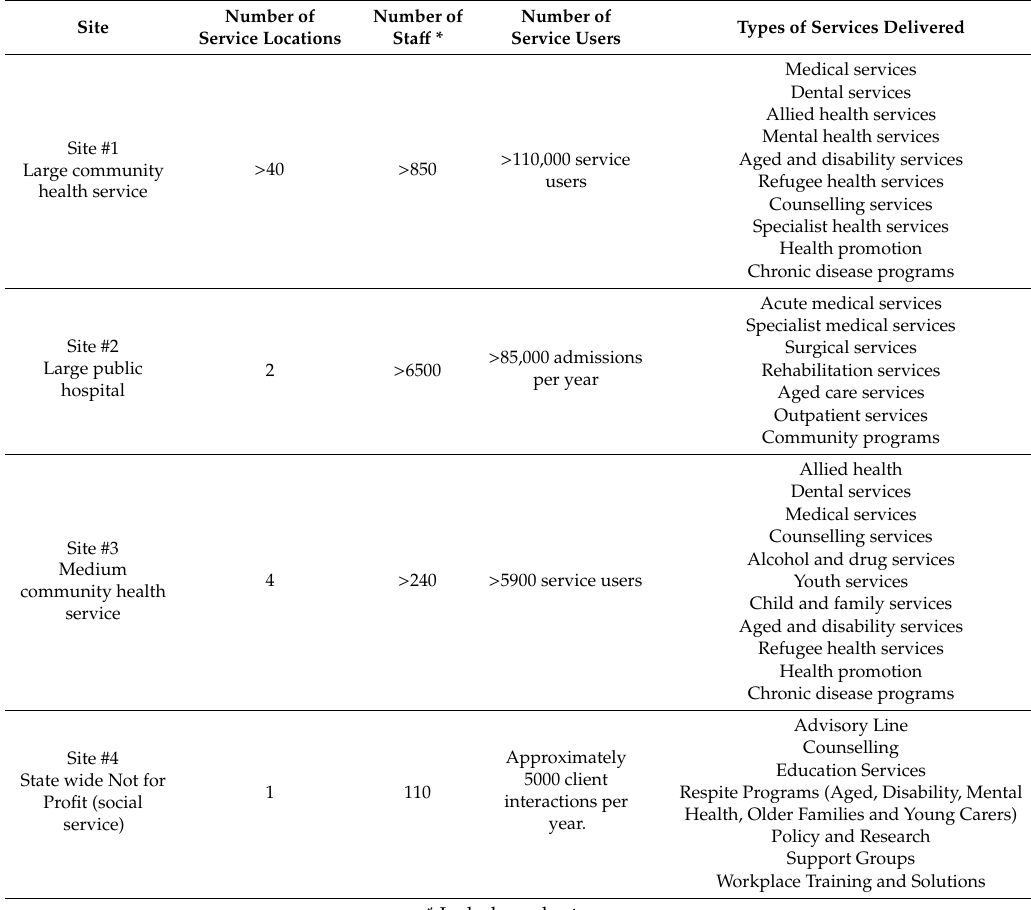
Table 1. Description of study